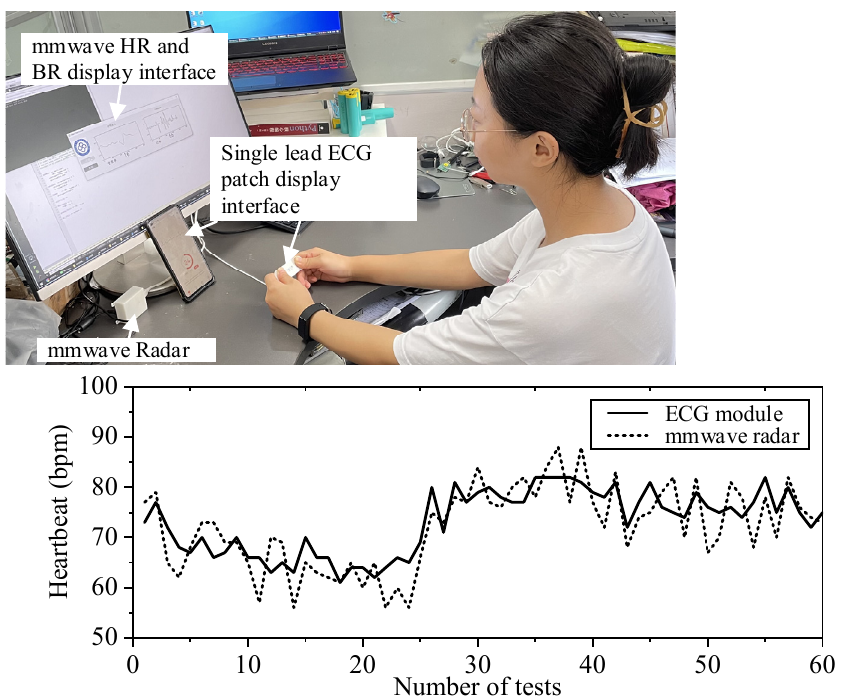
Figure 20. The comparative experiment of millimeter wave radar and single channel ECG module.